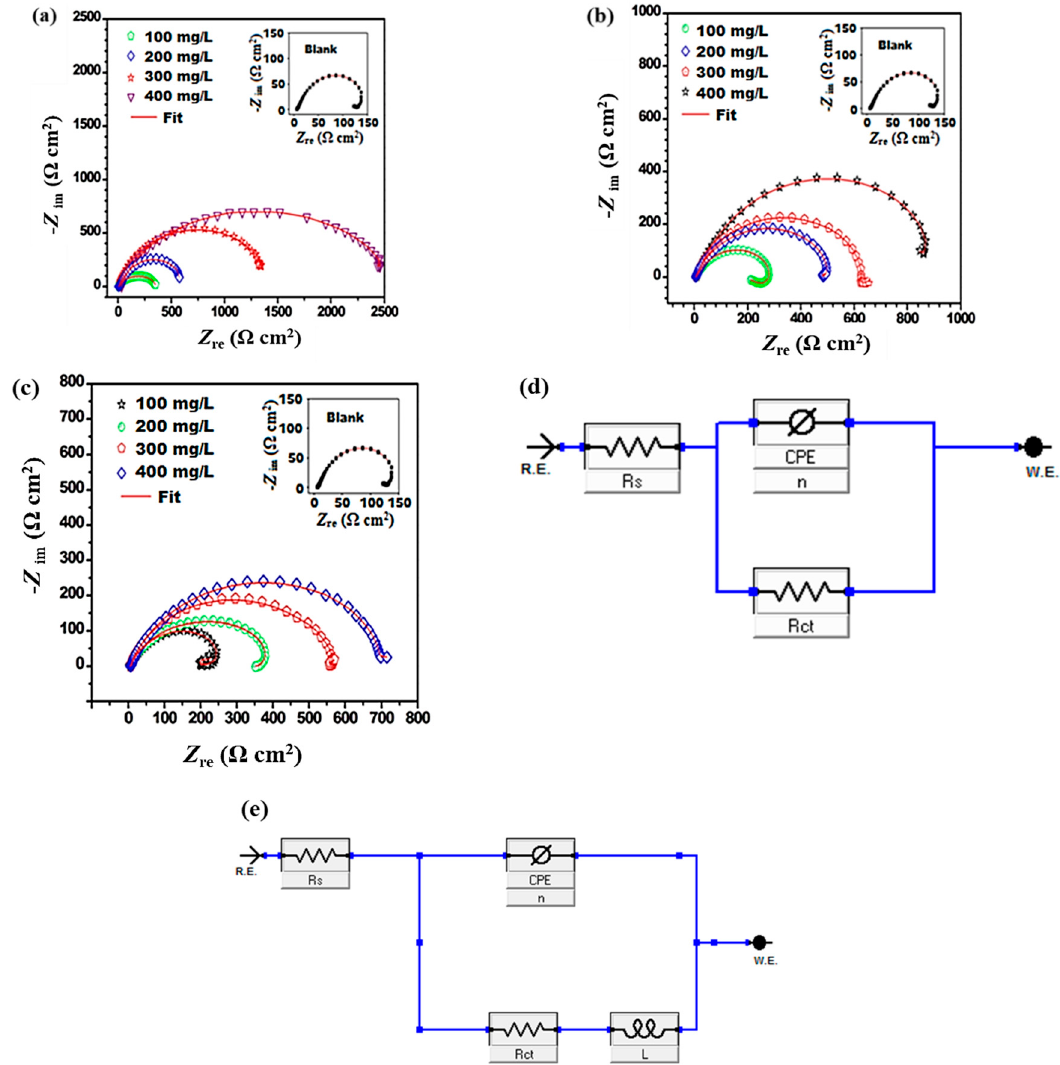
Figure 3. Nyquist plots in absence and presence of different concentration of inhibitors: ( a ) TMI; ( b ) DMI; ( c ) MMI; ( d , e ) Equivalent circuits used.